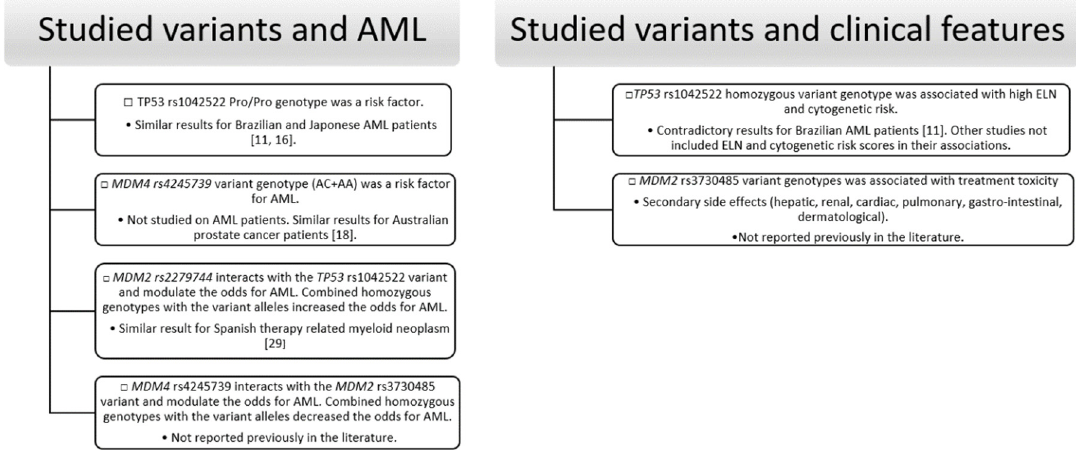
Figure 1. Summary diagram of significant results of the association analysis.